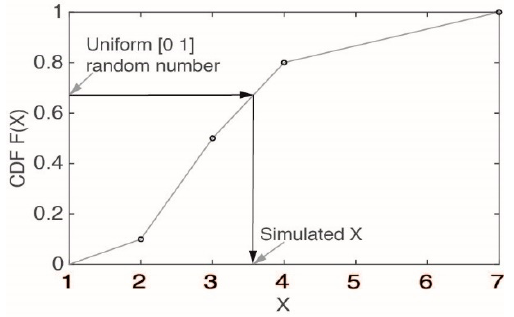
Figure 5. Schematic plot of a univariate Monte Carlo simulation. The solid points are the measured v alues.